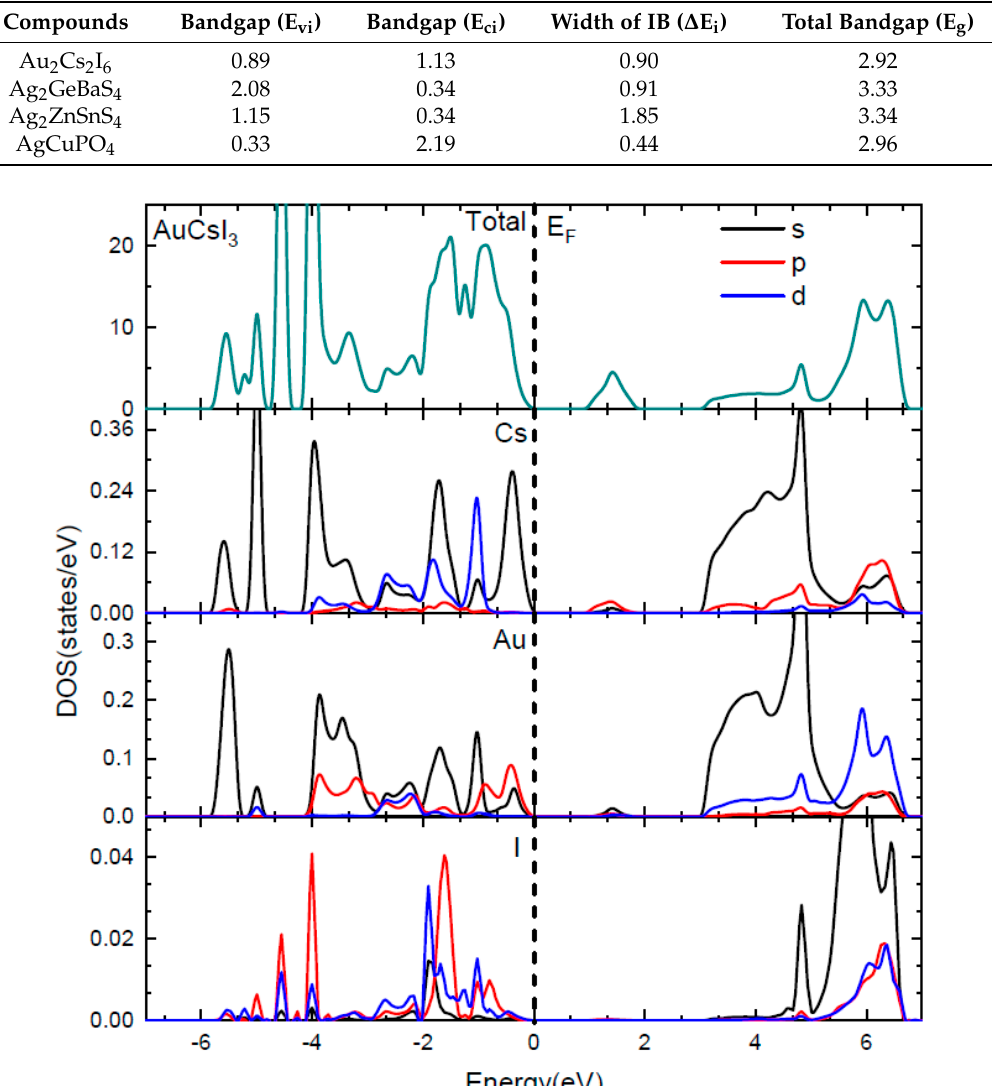
Figure 3. Total and site projected density of states (PDOS) of Au 2 Cs 2 I 6 . The Fermi level is conventionally set to zero and indicated with a dashed line.